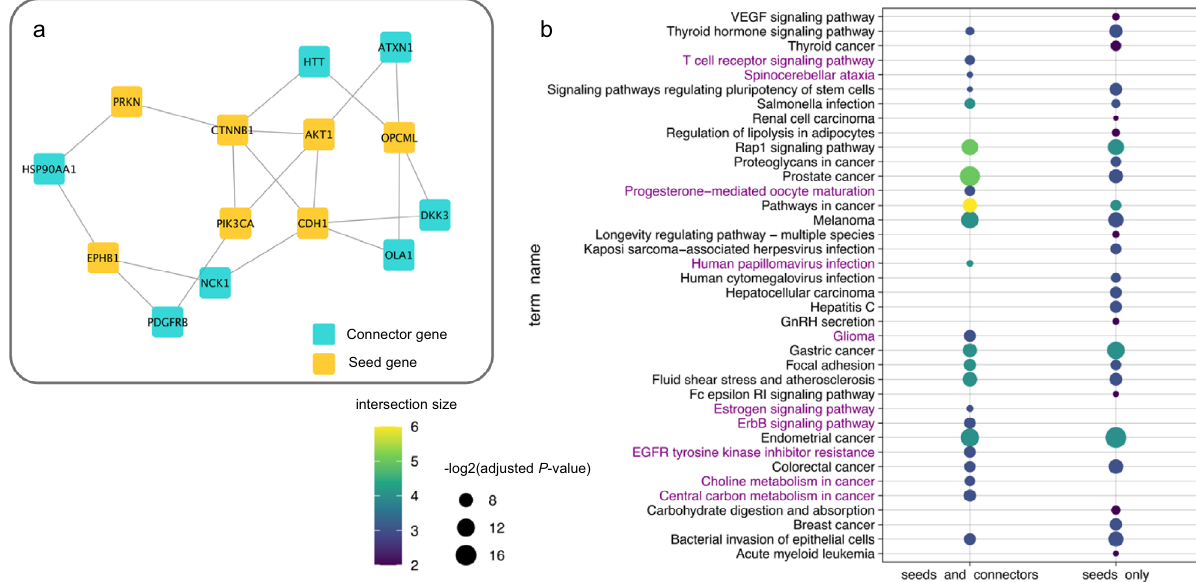
Fig. 3 Ovarian cancer disease pathway identi fi cation by MuST. a The OC disease module derived by MuST using NeDRexDB OC-associated genes (seeds). b Comparison of KEGG enriched pathways obtained with seed and connector genes vs. obtained using seed genes alone. Pathways which could only be retrieved after adding connector genes are marked in